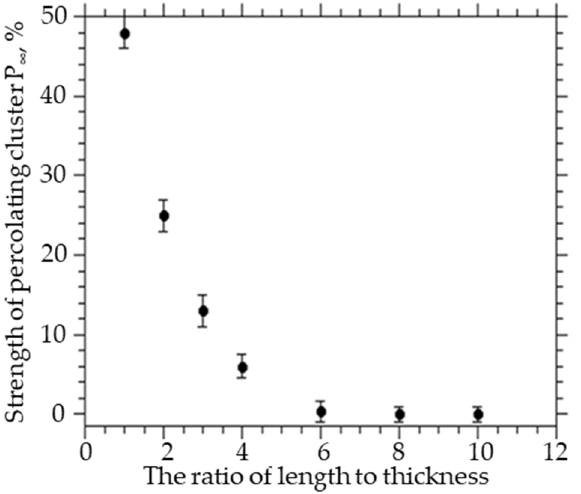
Figure 2. The strength of the percolation cluster at different ratios of lateral dimensions to the thickness of the matrix.